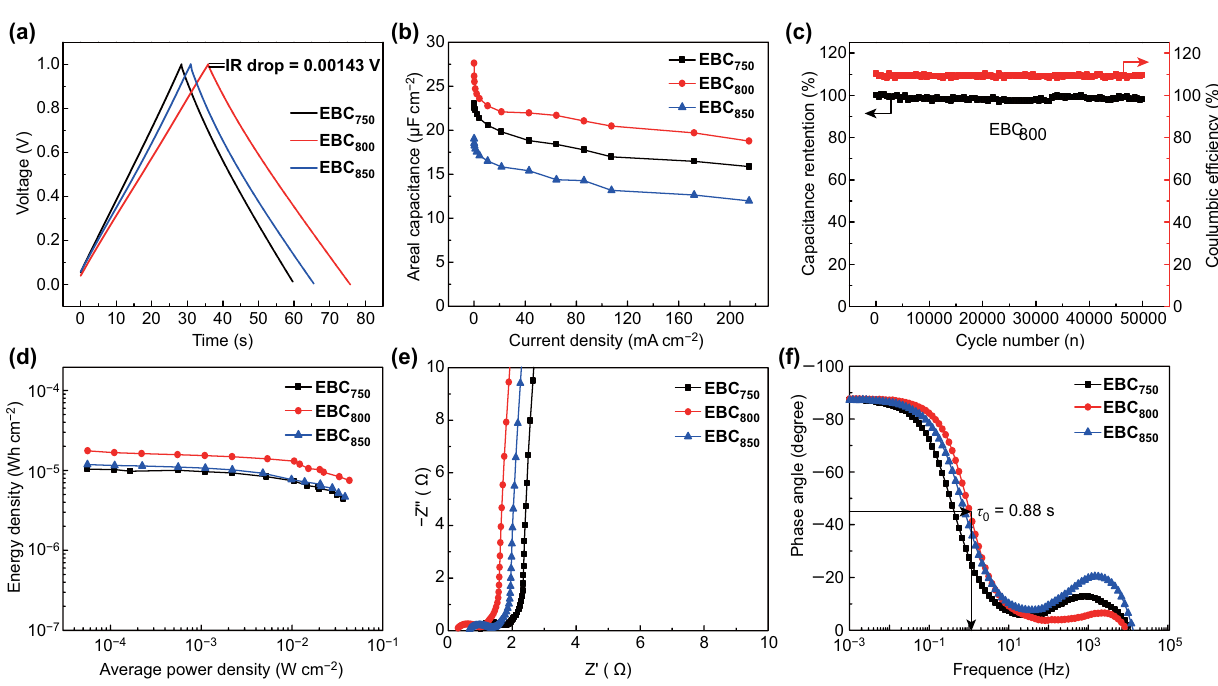
Fig. 6 a GCD curves of EBC electrodes at 1 A g −1 . b Areal capacitance of EBC electrodes at various current densities. c Capacitance retention and coulombic efficiency of EBC 800 -based SC after 50,000 cycles at 10.75 mA cm −2 . d Ragone plots of EBC capacitors. e Nyquist plots of EBC electrodes. f Bode plots of phase angle versus